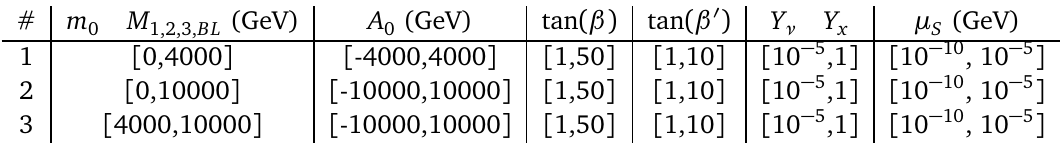
Table 1: The initial parameter ranges for the three different scanning ranges. The parameters are defined and sampled at the GUT